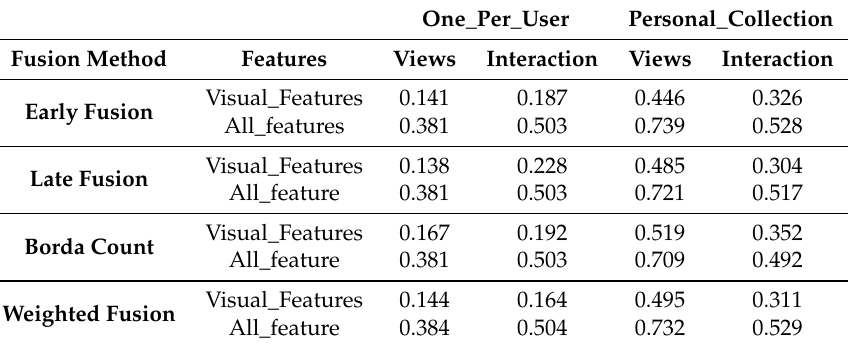
Table 10. Performance of fusion techniques in the prediction of images popularity using SVR